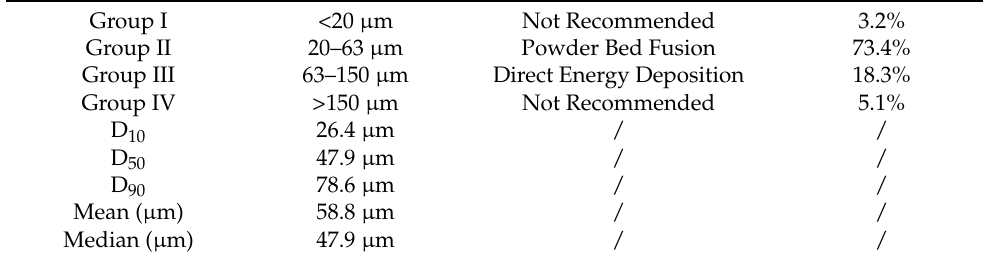
Figure 6. Incremental particle size distribution (PSD) curves for three spheroidised Ti6Al4V powder samples as determined with the laser diffraction technique. Table 2. Numerical PSD results for the three spheroidised Ti6Al4V powder samples determined with the laser diffraction